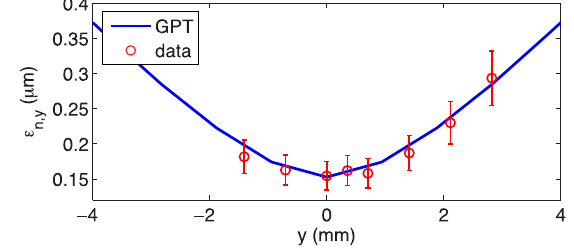
FIG. 3. Measured and simulated vertical emittance as a function of misalignment going into the first SRF cavity, set on crest at 1500 kV cavity voltage. All other SRF cavities were off.